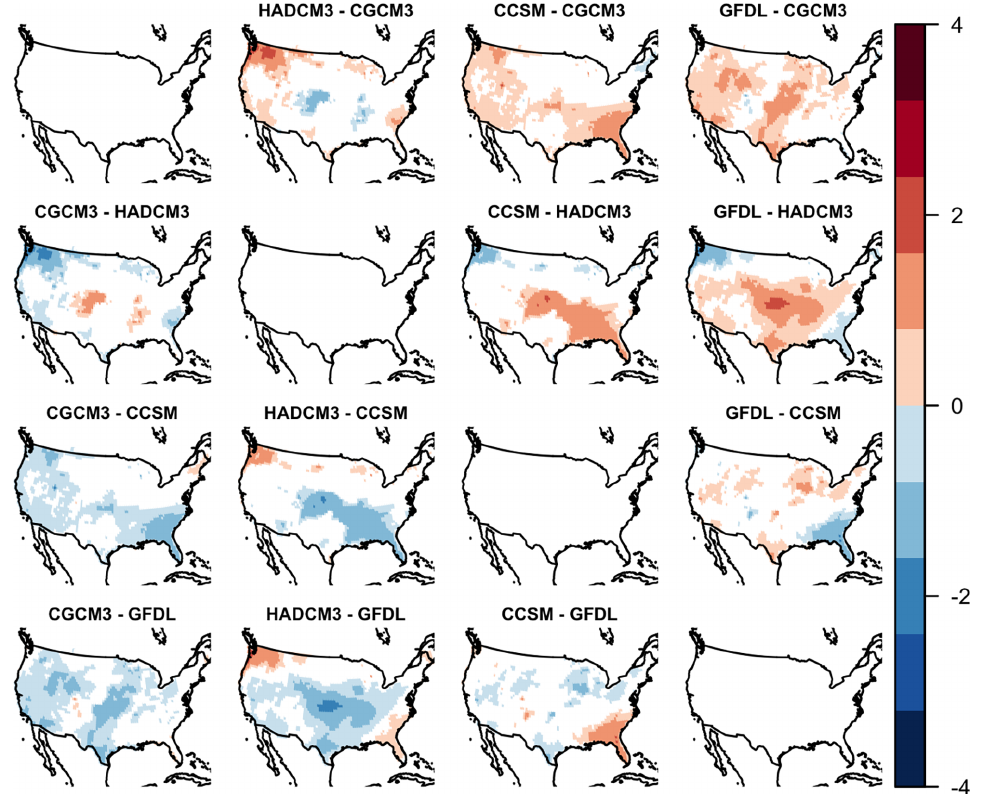
Figure 8. A heat map of the estimated average pairwise difference in GCM effect for the APL model. Only significant locations at the 0.10 level using pointwise inference are